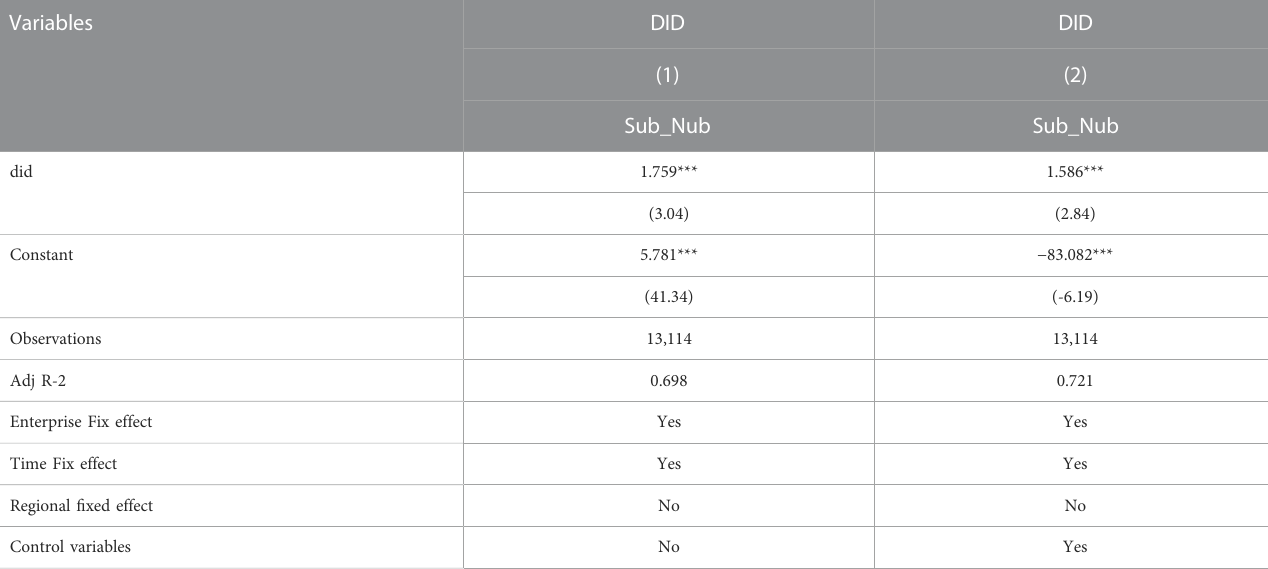
TABLE 2 Baseline regression. Variables